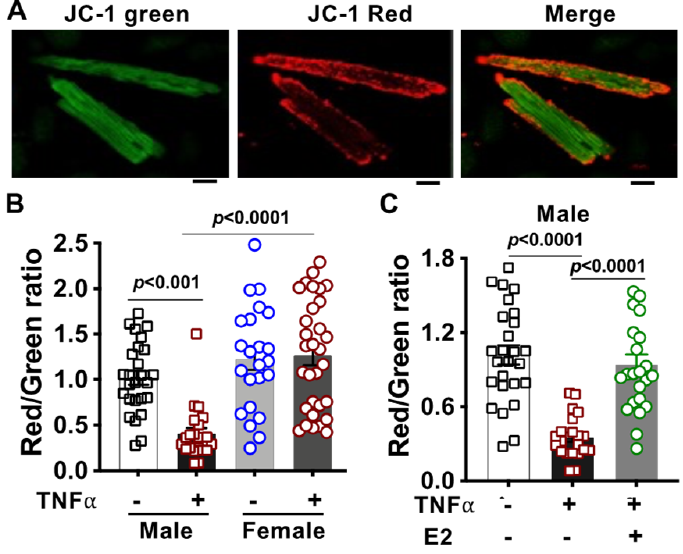
Figure 6. Effects of TNF α and E2 on mitochondrial membrane potential in adult cardiomyocytes. ( A ) Representative images of mitochondrial membrane potential using JC-1 in adult mouse cardio- myocytes. Scale bar = 20 μ m. ( B ) Changes of mitochondrial membrane potential in cardiomyocytes